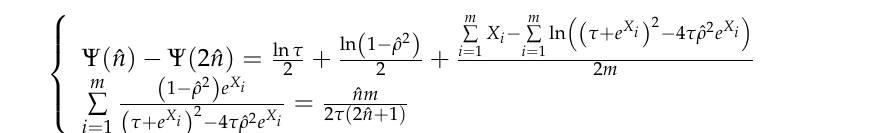
Figure 3. VHF-band SAR image pair (vehicles are located in red boxes) used to the second experiment: ( a ) reference image of pass 3 in mission 5; ( b ) test image of pass 3 in mission 3. Note that the sketch of target deployment is also given in this figure. 3.2. Model Fitting We test the proposed model and parameter estimation by applying it to the data described above. It is worth noting that the distribution of the LR image is expected to be close to Gaussian [33,36]. However, several studies, e.g., [28,33], have shown that a Gaussian approximation is not sufficiently accurate to characterize the LR statistics in practice. Instead, a more general and accurate parametric model, i.e., the GG model, was adopted to describe the statistical behavior of the LR images. Although the GG model is still empirical, it is an attractive candidate for modeling LR images, and has proven to be useful for change detection in SAR images [3,28,33]. Hence, to assess the modeling capability of the proposed model, we compare it with the GG model in this investigation. The GG distribution is characterized by the following PDF [37,38]